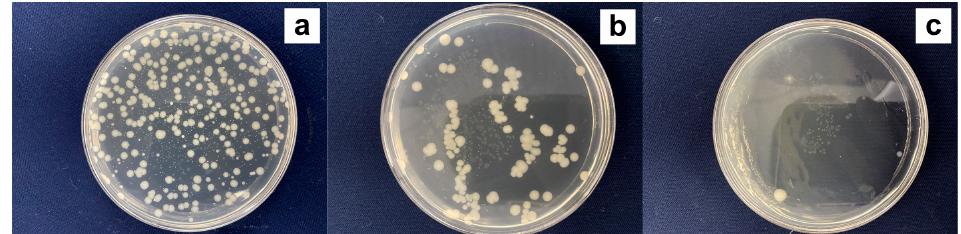
Figure 6. Visual bacterial cultures for undyed cotton fabric ( a ) and dyed cotton fabrics with 5% ( b ) and 10%owf ( c ) GSE.